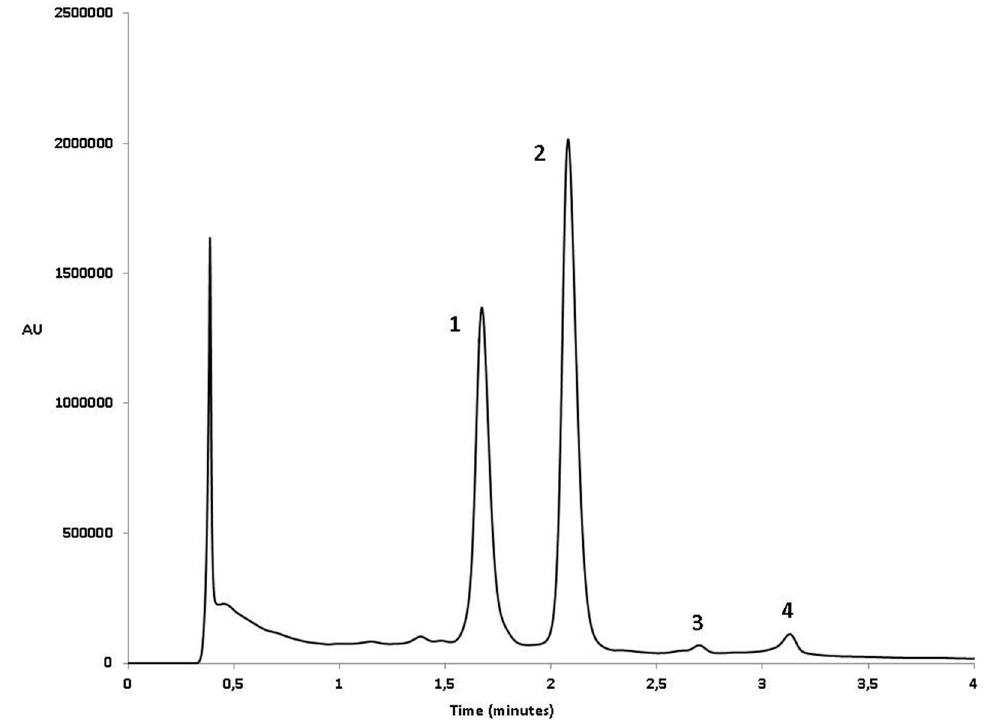
Figure 1. Chromatogram of the anthocyanins in an açai extract ( λ = 520 nm). (1) cyanidin 3- O -glucoside; (2) cyanidin 3- O -rutinoside; (3) peonidin 3- O -glucoside; and (4) peonidin 3- O